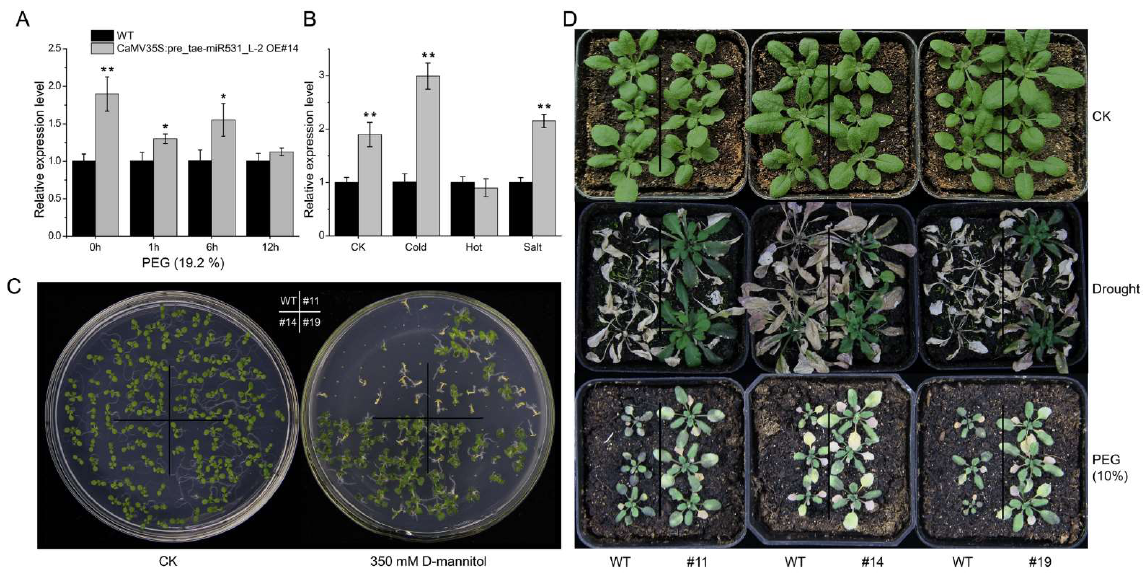
Figure 4. Overexpression of the tae-miR531_L-2 precursor in Arabidopsis thaliana . ( A , B ) The expression level of tae-miR531_L-2 in T 3 transgenic line ( tae-miR531_L-2 ) and wild type (WT) seedlings under drought (20% PEG, 0 h, 1 h, 6 h and 12 h), cold (4 °C, 6 h), heat (37 °C, 6 h), and salt (300 mM NaCl, 6 h) stresses. Error bars represent the SD, * p < 0.05; ** p < 0.01. ( C ) Germination rate experiment of transgenic lines and WT. Seeds of WT and transgenic lines were germinated on half-strength Murashige and Skoog (MS) agar plates containing 0 mM and 350 mM D-mannitol for two weeks. ( D ) Drought resistance detection in the seedling stage. Two-week-old soil-grown seedlings were air-dried and then rehydrated to detect extreme drought resistance. The seven-day-old soil-grown seedlings were watered with 10% PEG solution for two weeks for drought resistance detection under prolonged mild